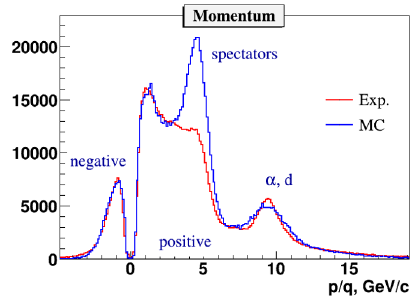
Figure 7. Comparison of momentum distributions for the negative and positive particles reconstructed in the experimental data and MC